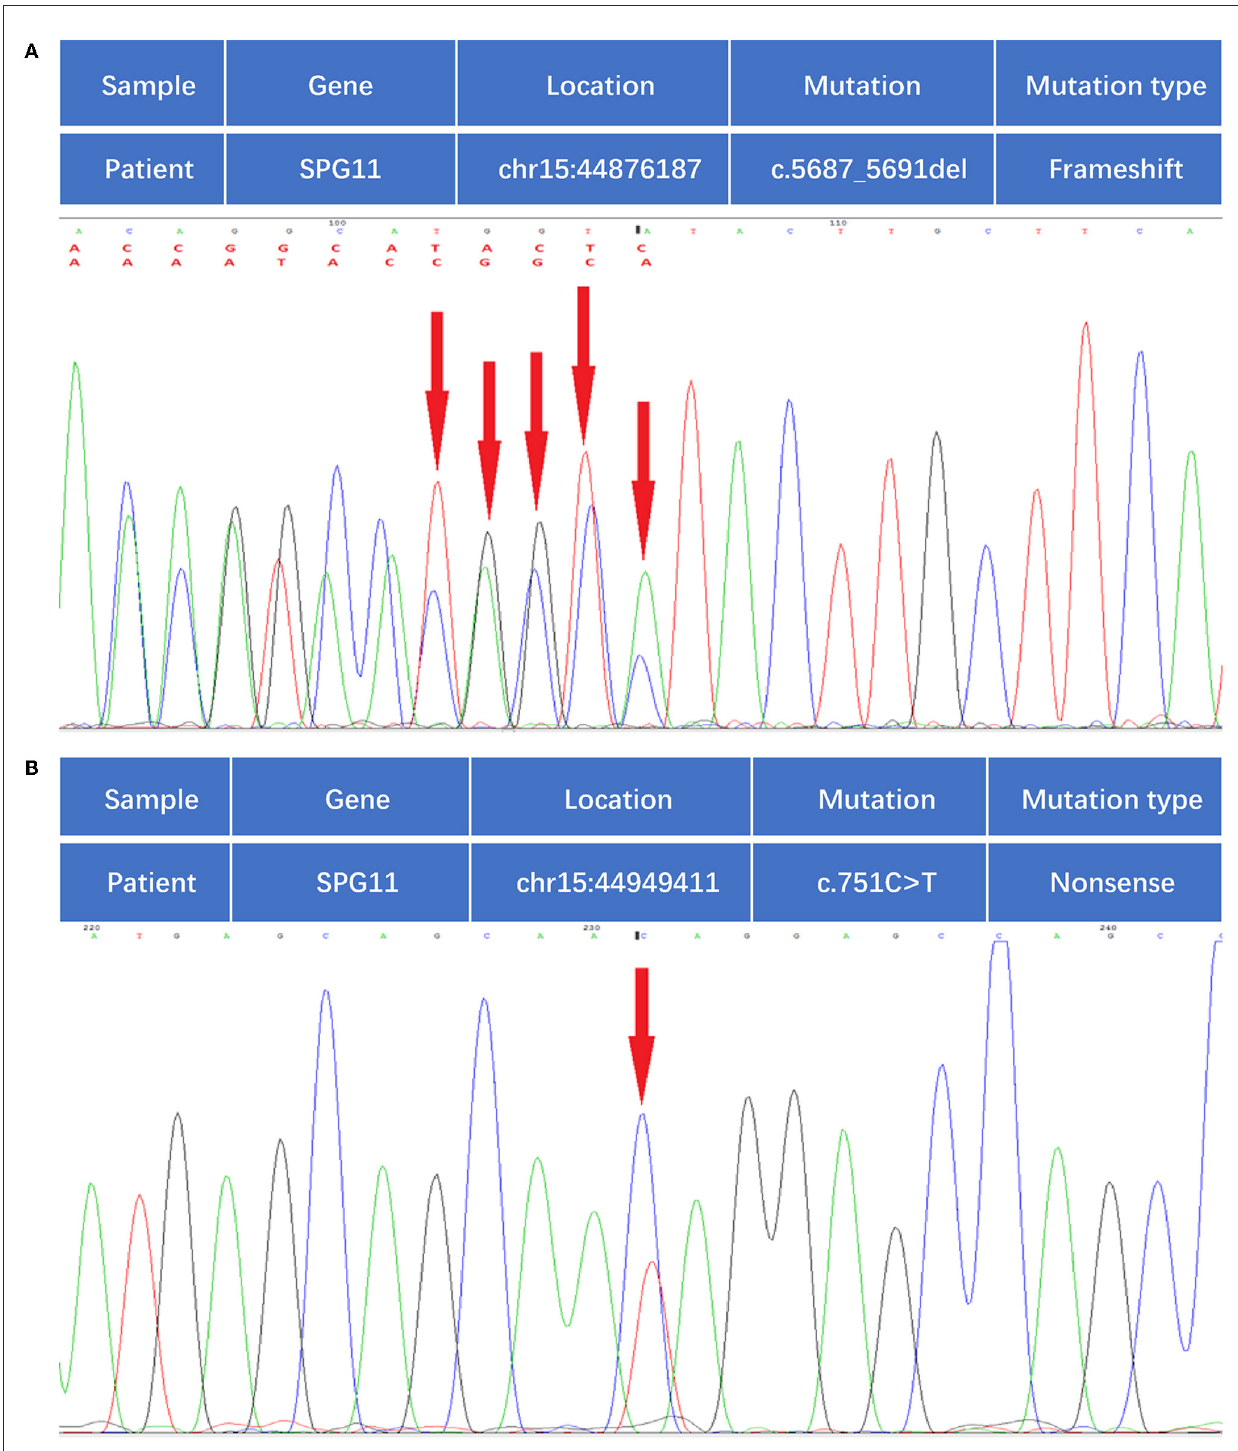
FIGURE3 Whole-genome sequencing identified compound heterozygous mutations in the SPG11 gene. (A) Mutation of c.5687-5691del, as indicated by the red arrow. (B) Mutation of c.751C > T, as indicated by the red arrow.